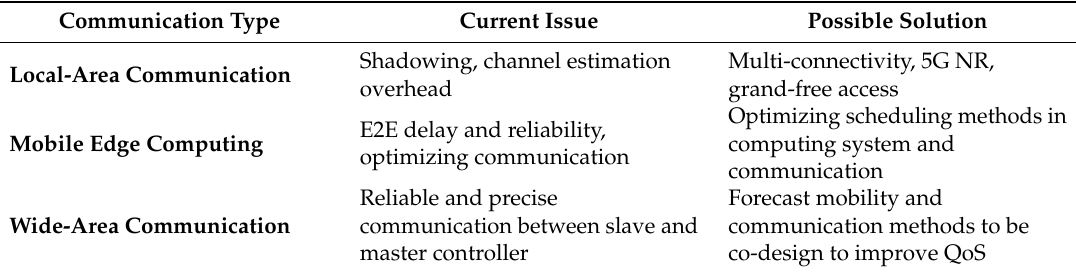
Table 7. Possible solutions to improve existing issues in communication methods [63].